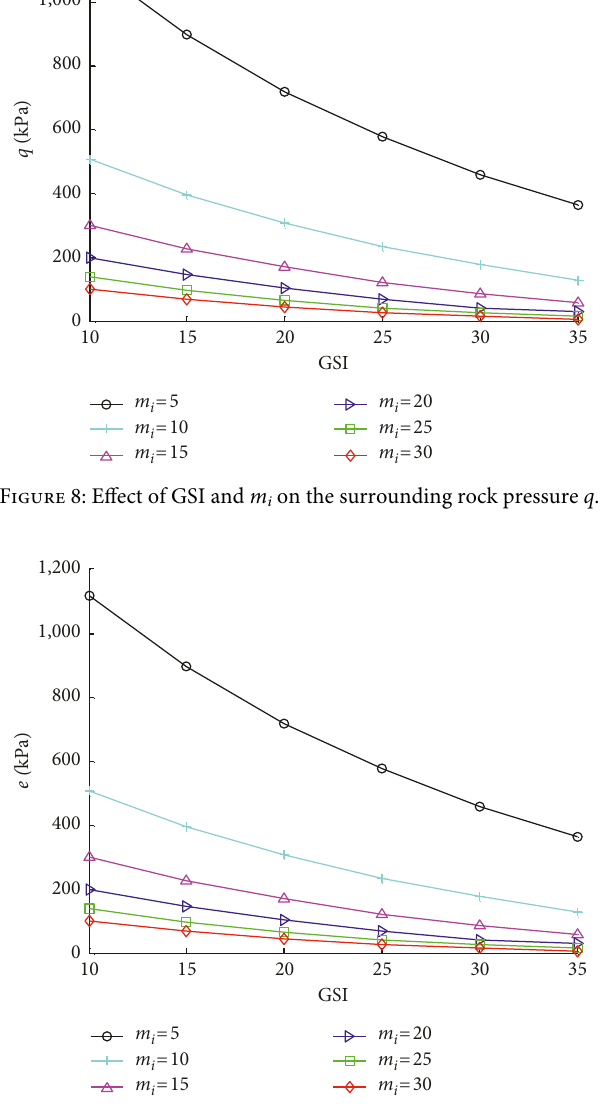
Figure 9: Effect of GSI and m i on the surrounding rock pressure e